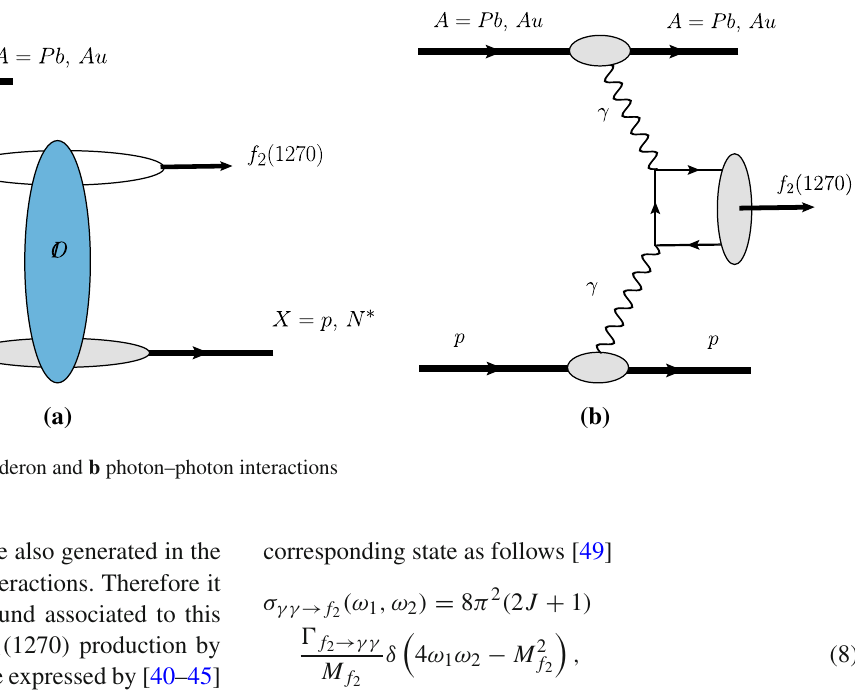
Table 1 Cross sections in μ b for the f 2 ( 1270 ) production at different rapidity ranges in photon – Odderon ( γ IO ) and photon – photon ( γγ ) √ s = 8 . 1 TeV) and pAu collisions at RHIC ( interactions in pPb collisions at LHC ( ALICE/CMS ( − 2 . 0 ≤ Y ≤ + 2 .